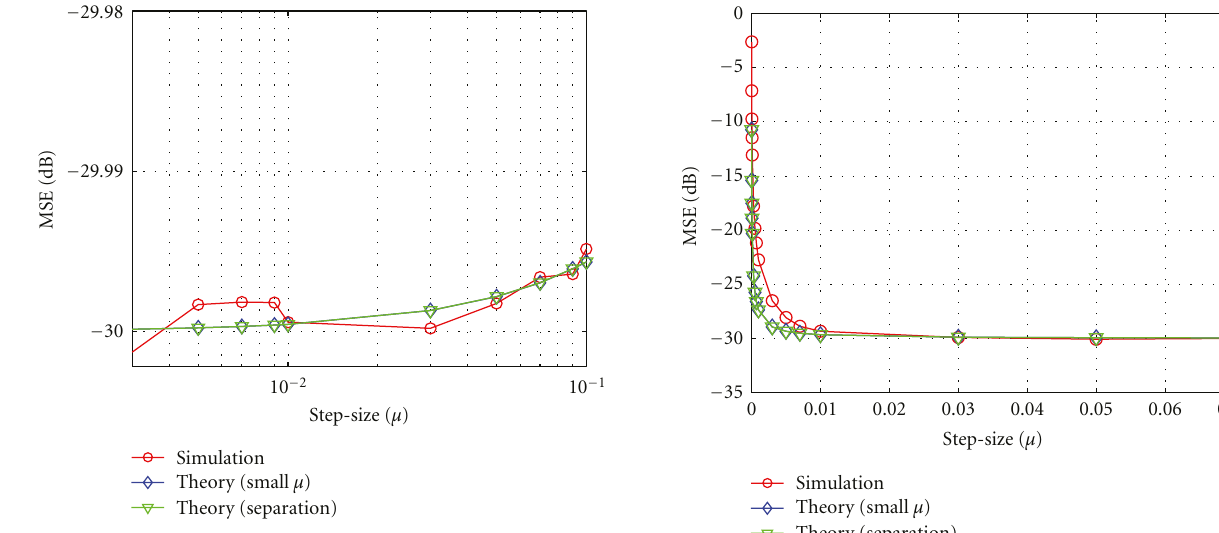
Figure 3: Theoretical and simulated MSE learning curves of the SRLMF algorithm using correlated Gaussian regressors with shift structure with SNR = 30dB.